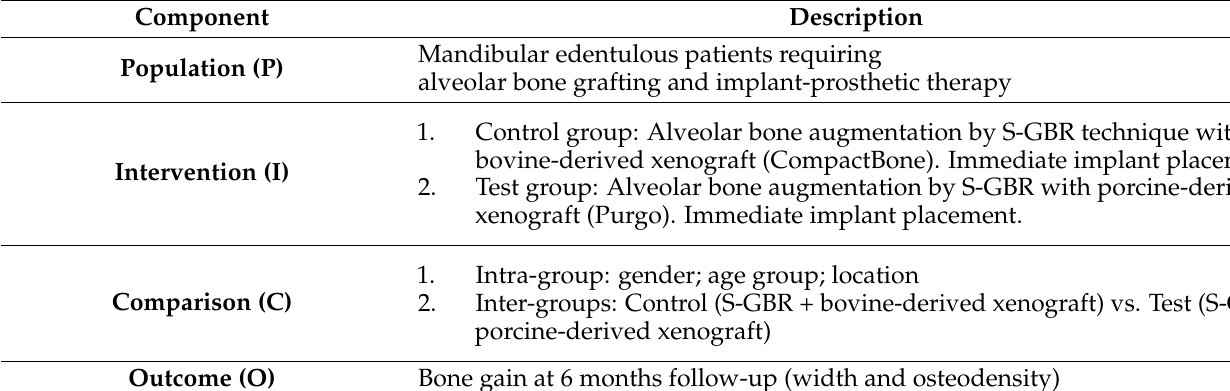
Table 2. Study design (PICO).